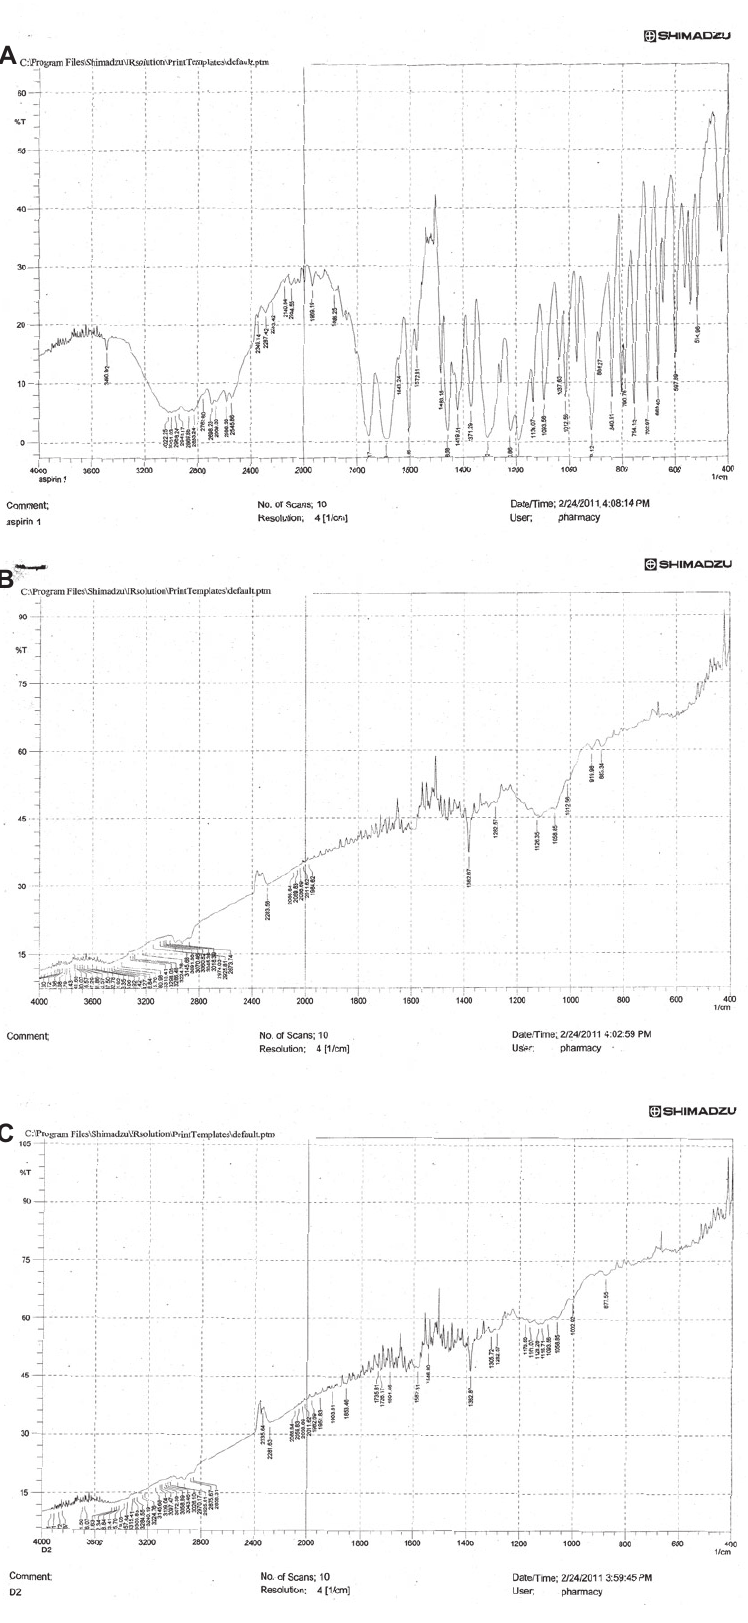
Figure 7 FTIR spectra of (A) pure aspirin, (B) blank ethyl cellulose microparticles and (C) aspirin-loaded ethyl cellulose